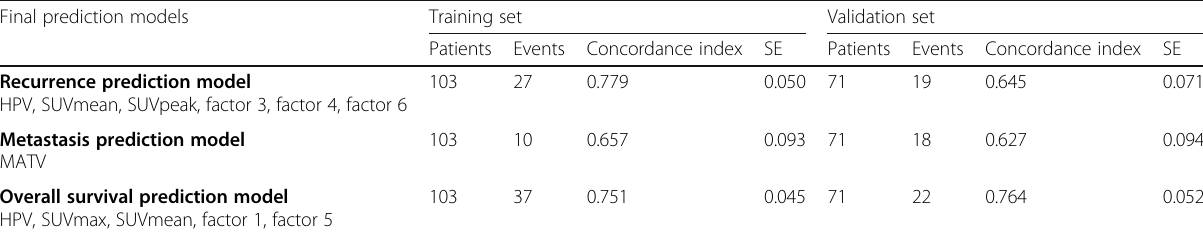
Table 4 The accuracy of the prediction models for recurrence, metastasis, and overall survival in the training set and validated in the validation set. For the recurrence prediction, the combination of HPV, SUVmean, SUVpeak, factors 3, 4, and 6 was most accurate. For the metastasis prediction, the use of only MATV was most accurate. For overall survival prediction, the combination of HPV, SUVmax, SUVmean, factors 1 and 5 was most accurate